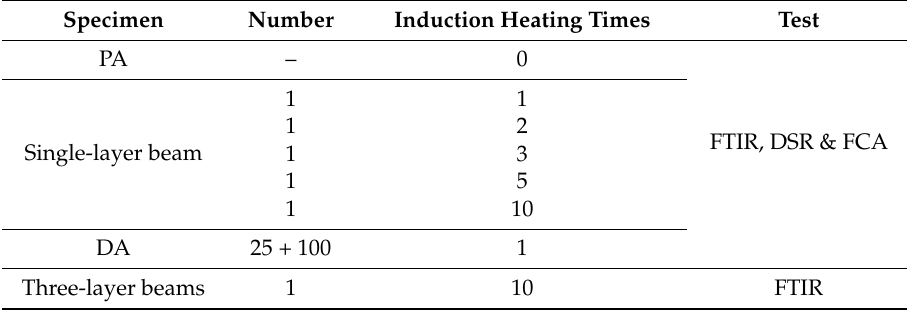
Figure 8. Extraction and storage of asphalt binder coated on Dramix steel fibers.